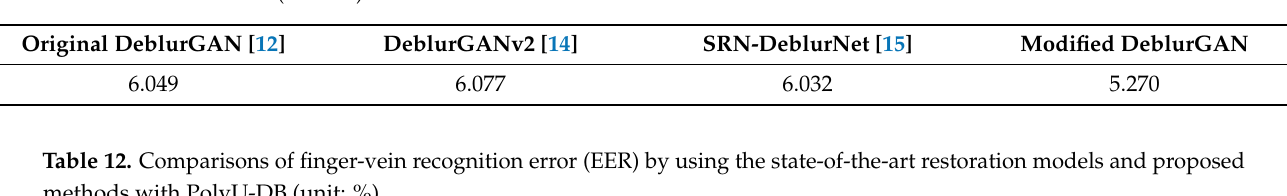
Table 11. Comparisons of finger-vein recognition error (EER) by using the state-of-the-art restoration models and proposed methods with SDU-DB (unit: %).